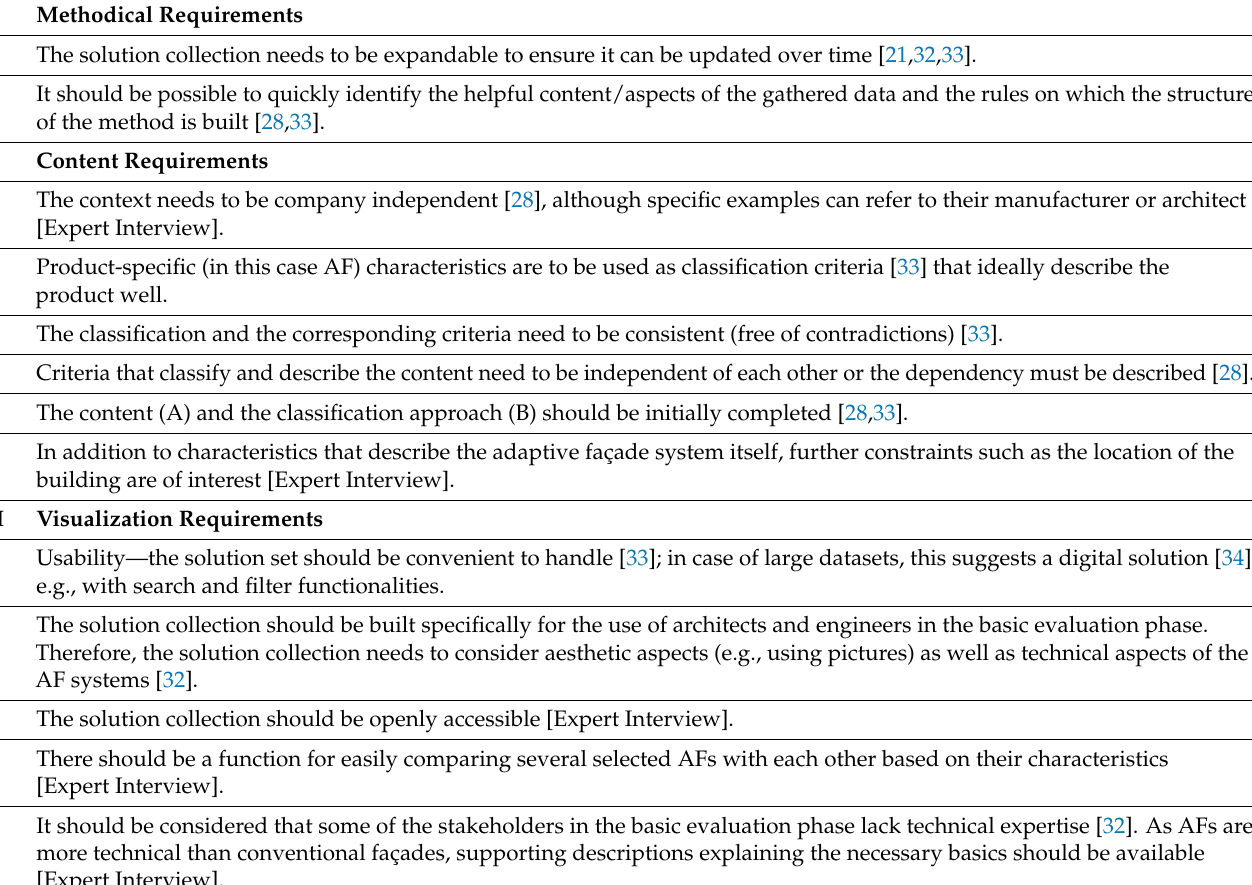
Table 1. Requirements for the solution collection of adaptive